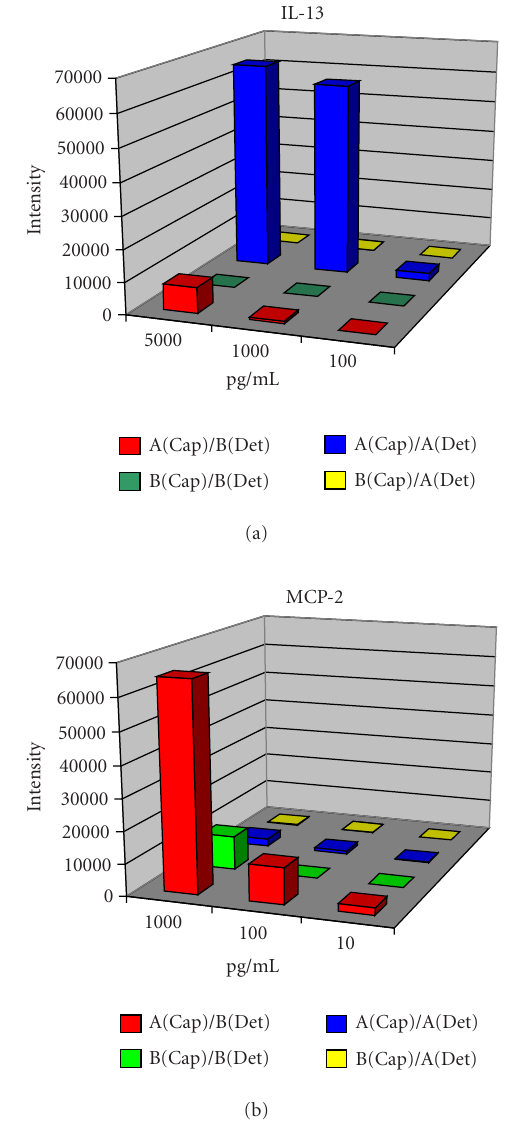
Figure 2. Optimization of antibodies from di ff erent sources (A and B) for choosing optimal pair for immunoassay on protein microarray with examples of (a) IL-13 and (b) MCP-2. approaches: (1) choosing optimal capture and detection antibody pairs for the microarray immunoassay and (2) optimizing assay procedures.